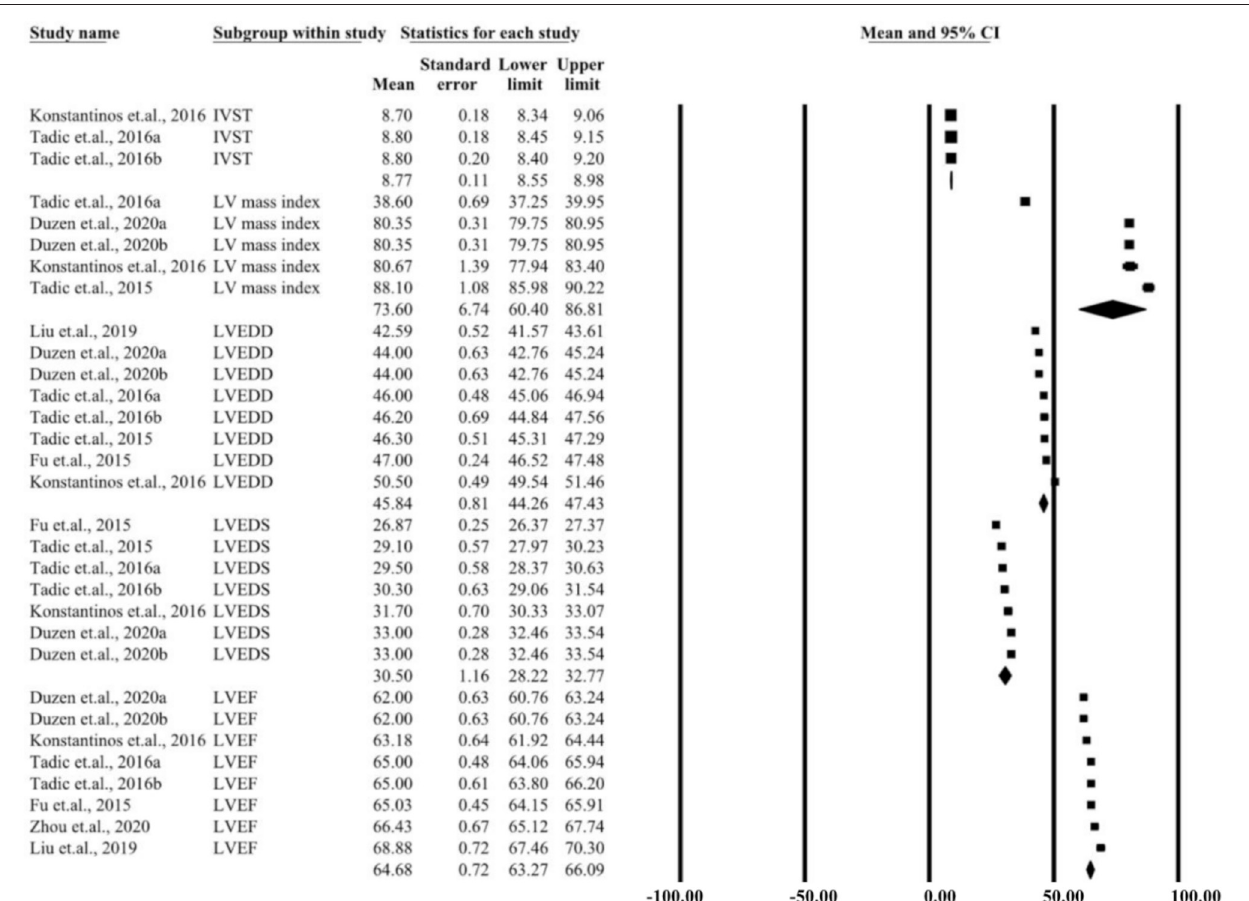
FIGURE 2 | Summary of two-dimensional echocardiographic parameters for the left ventricular control group.